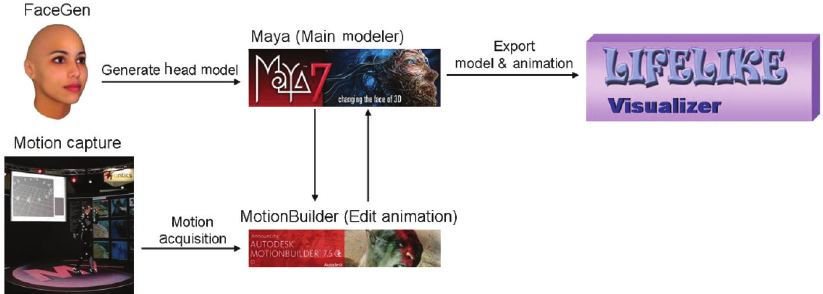
Figure 9. Graphical Asset Production